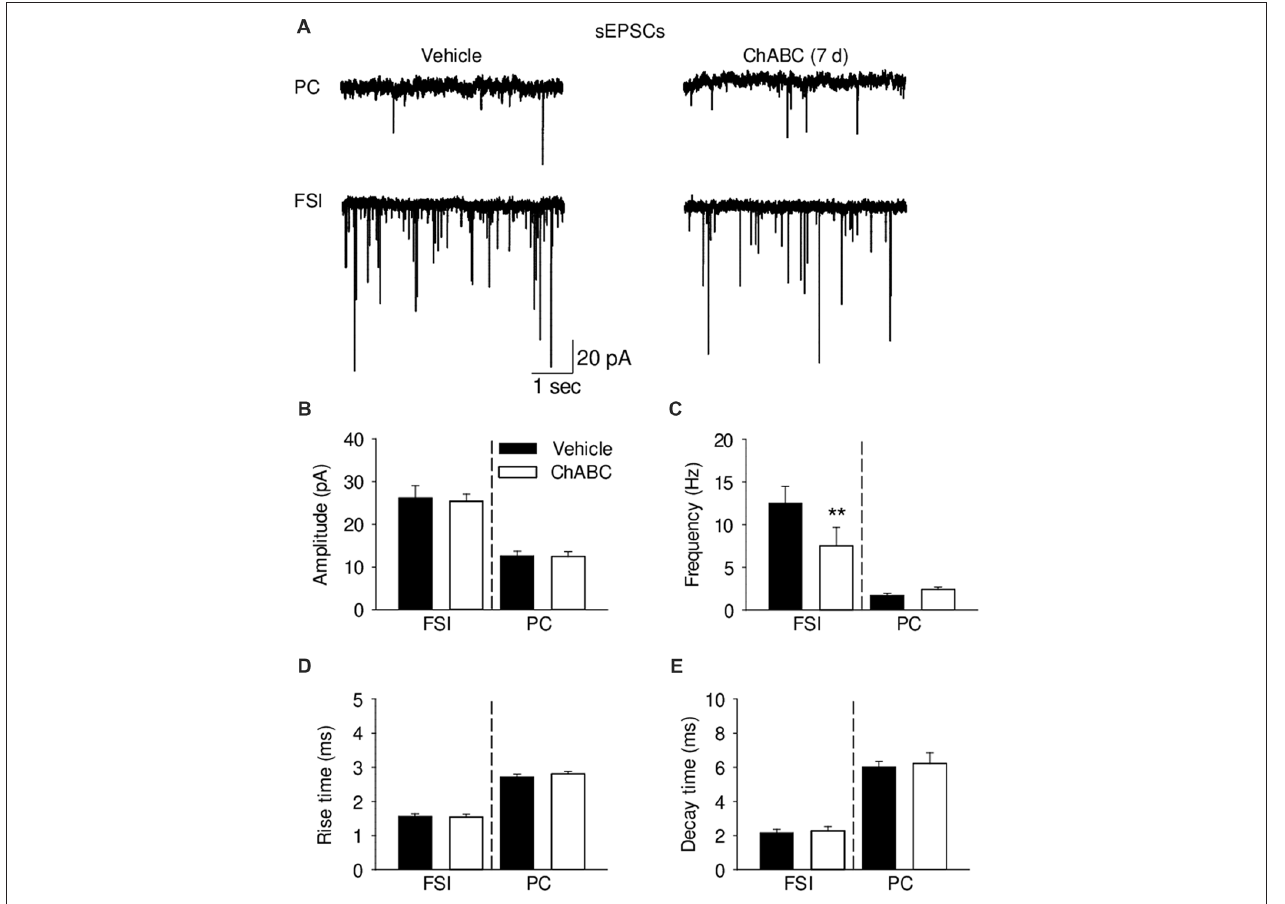
FIGURE 4 | Analysis of excitatory synaptic transmission onto pyramidal cells and fast-spiking interneurons 7 days (7 d) after intrahippocampal injection of ChABC. (A) Representative traces of spontaneous excitatory post-synaptic currents (sEPSCs) from CA2 PCs (upper trace) and FSIs (lower trace) in vehicle- and ChABC-injected mice. Bar graphs comparing ChABC- vs. vehicle-treated CA2 FSIs and PCs in terms of the sEPSC amplitude (B) , frequency (C) , rise time (D) and decay time (E) . Bars represent mean ± SEM values in vehicle- and ChABC-treated FSIs (Vehicle, n = 11; ChABC, n = 11) and PCs (Vehicle, n = 11; ChABC, n = 11), ∗∗ P < 0.01, U-test, compared with